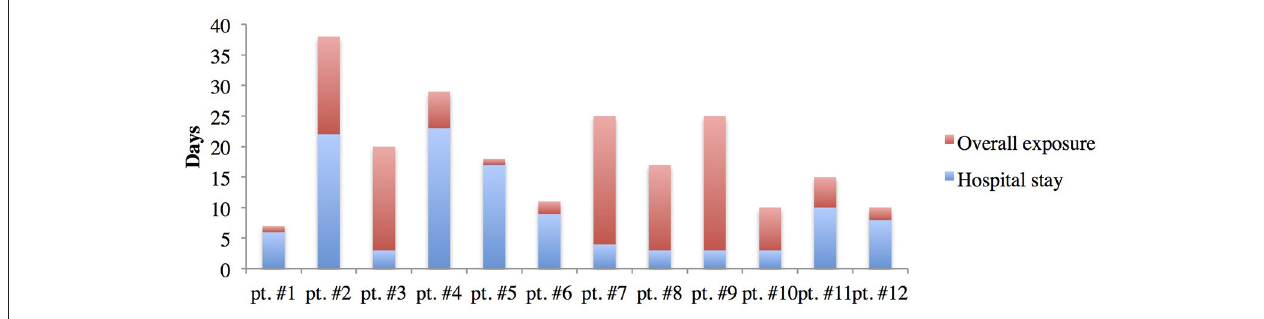
FIGURE 2 | Overall and in-hospital time of exposure of each caregiver to his/her SARS-CoV-2-infected child.